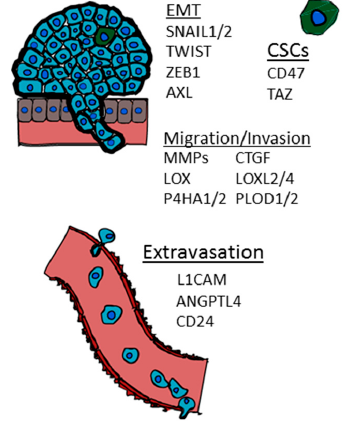
Figure 1. Hypoxia inducible genes that play a role in the epithelial to mesenchymal transition (EMT), cancer stem cell phenotype (CSC), migration, invasion, and extravasation.